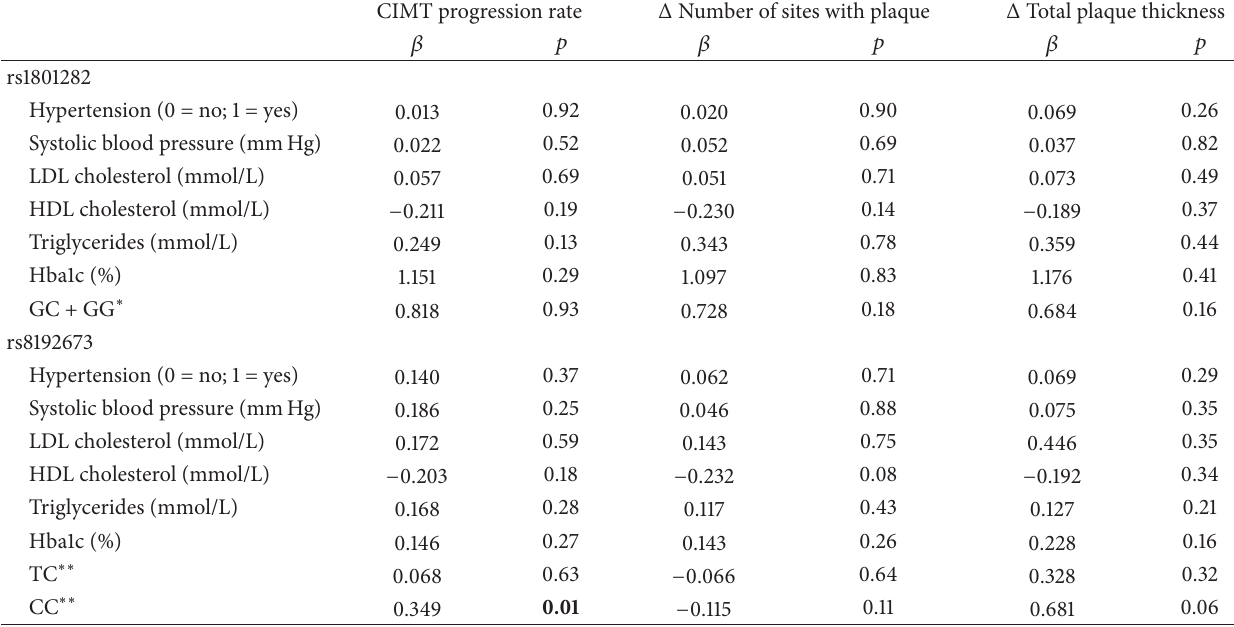
Table 6: Association of the rs1801282 genotypes with ultrasonographic markers of carotid atherosclerosis progression in patients with T2DM. CIMT progression rate Δ Number of sites with